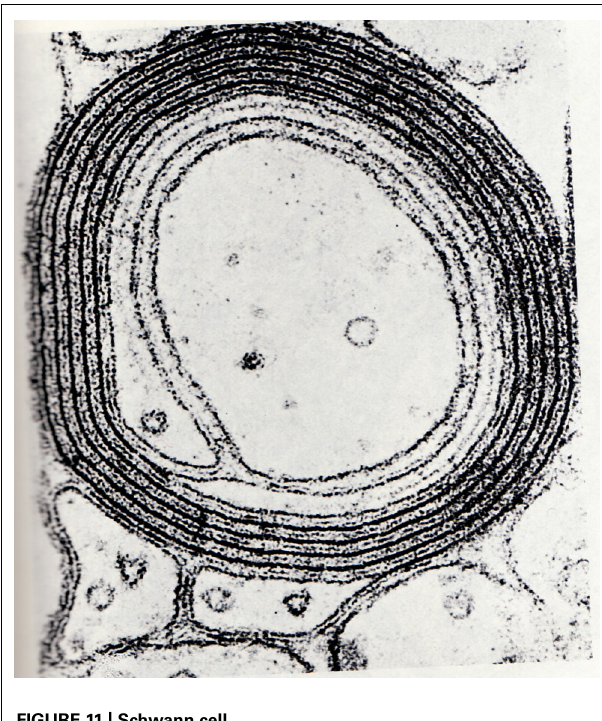
FIGURE 11 | Schwann cell.